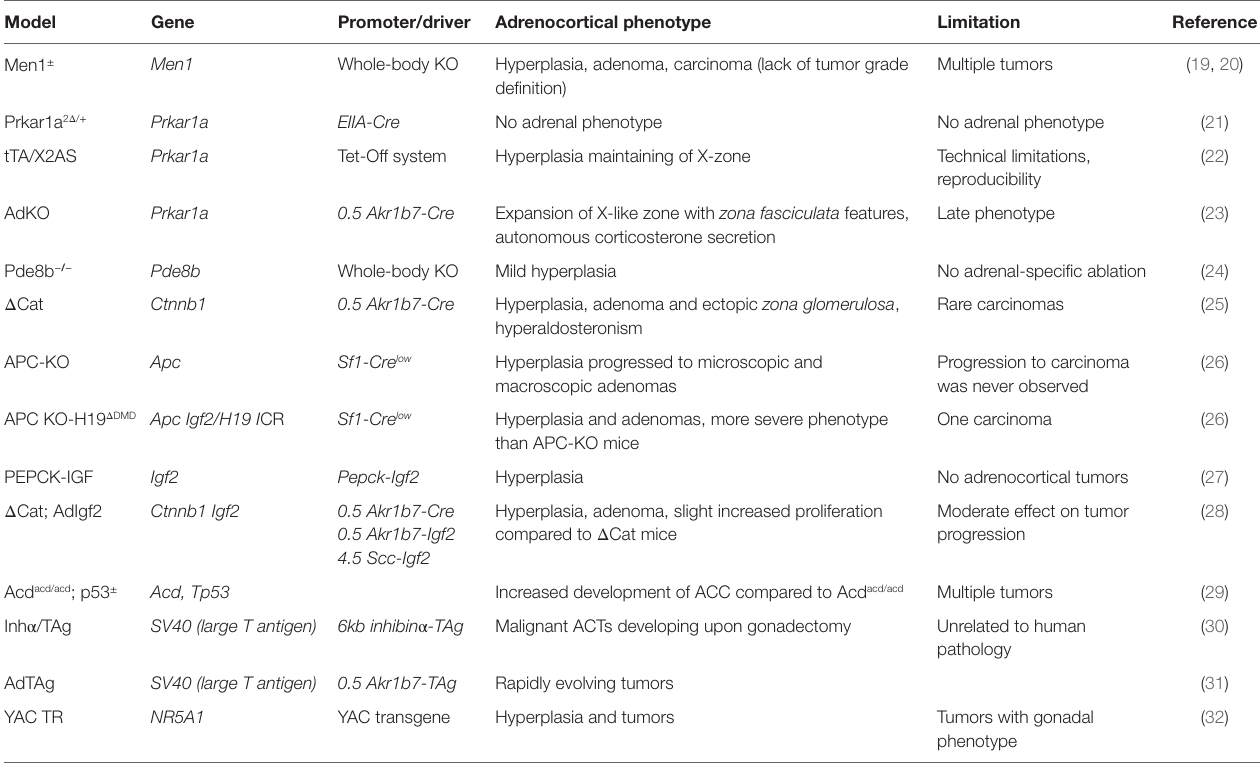
TABLe 1 | Current mouse models of adrenocortical tumors and their